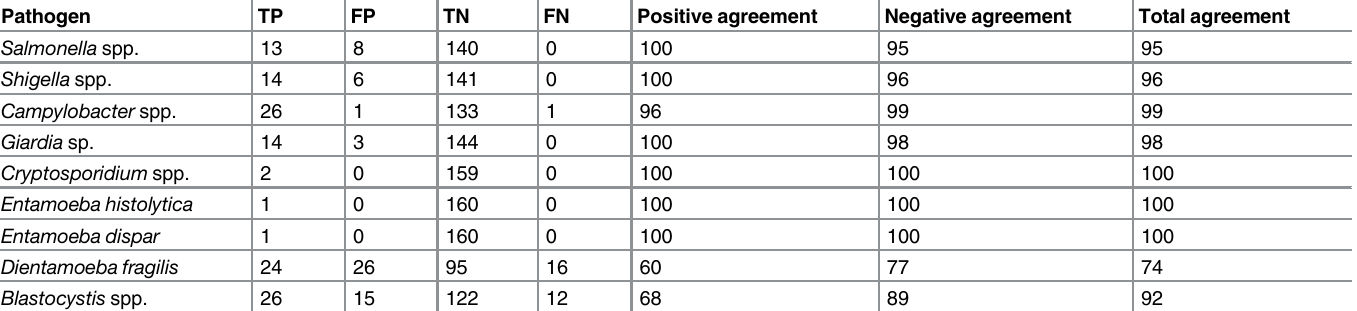
Table 2. Retrospective comparative study: performance of the NanoCHIP 1 GIP test versus the conventional tests used in the lab. TP, True Posi- tives; FP, False Positives; TN, True Negatives; FN, False Negatives. According to statistical analysis (Fisher exact test) the results are in concordance (p < 0.0001).